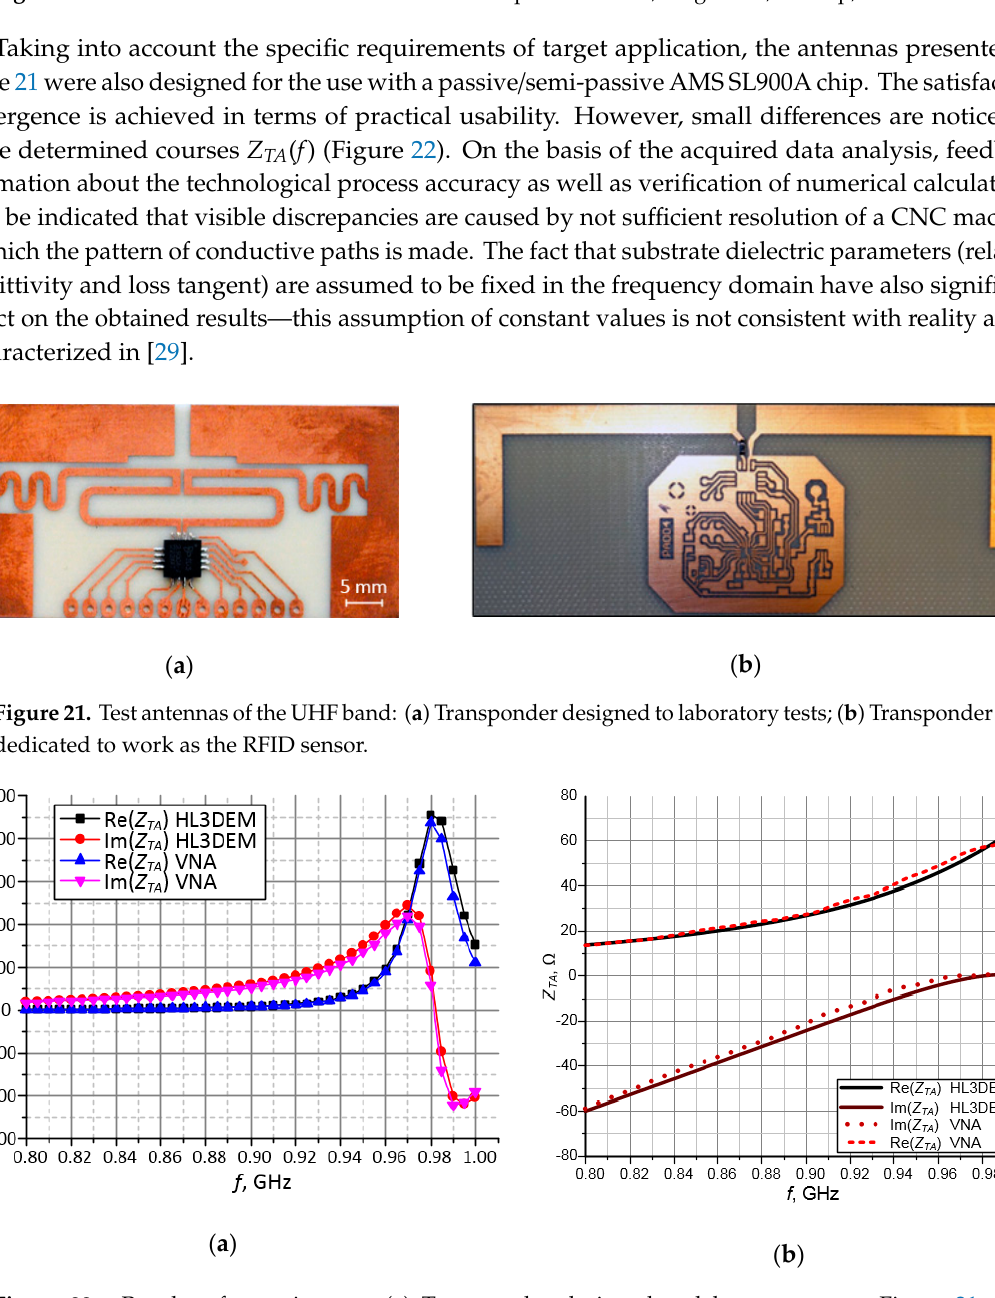
Figure20. UHFantennadedicatedtoAMSSL900Achip. 1—radiator; 2—ground; 3—chip;4—connector. Figure 20. UHF antenna dedicated to AMS SL900A chip. 1—radiator; 2—ground; 3—chip; 4—connector.